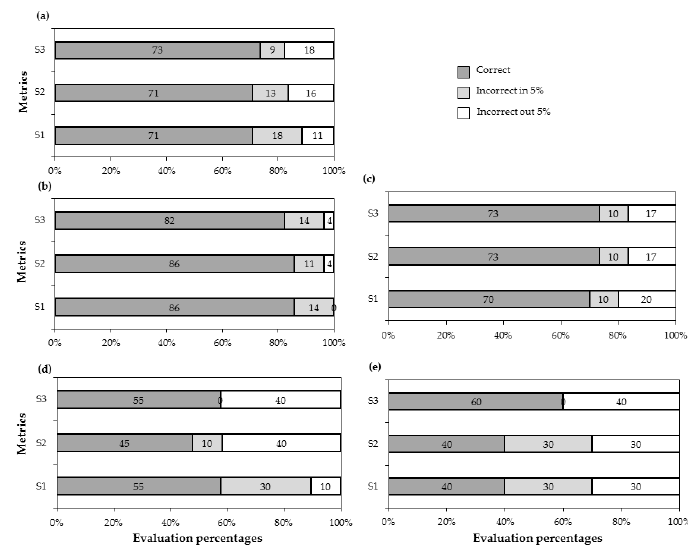
Figure 6. Comparison summative metric classifications (S1, S2, S3) with the NCS classification for two ecological quality classes, showing the percentage of correct and incorrect classifications, and the 5% interval of uncertainty. The results are reported for the ( a ) total sites and to each river type: ( b ) south limestones, ( c ) south small, ( d ) south medium–large, and ( e ) south mountains.